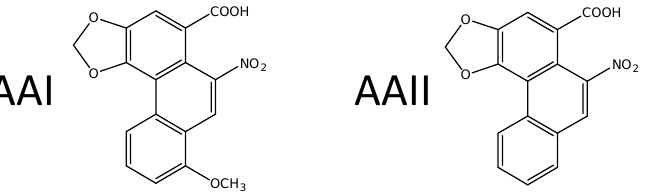
Figure 1. The major components of the AA plant extract, aristolochic acid I (AAI) and aristolochic acid II (AAII).